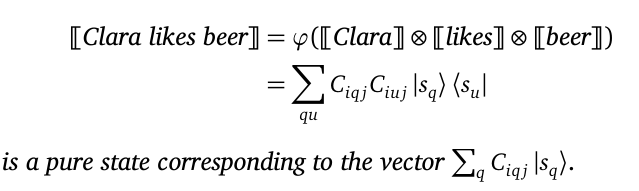
Figure 6: A transitive sentence in C with pure